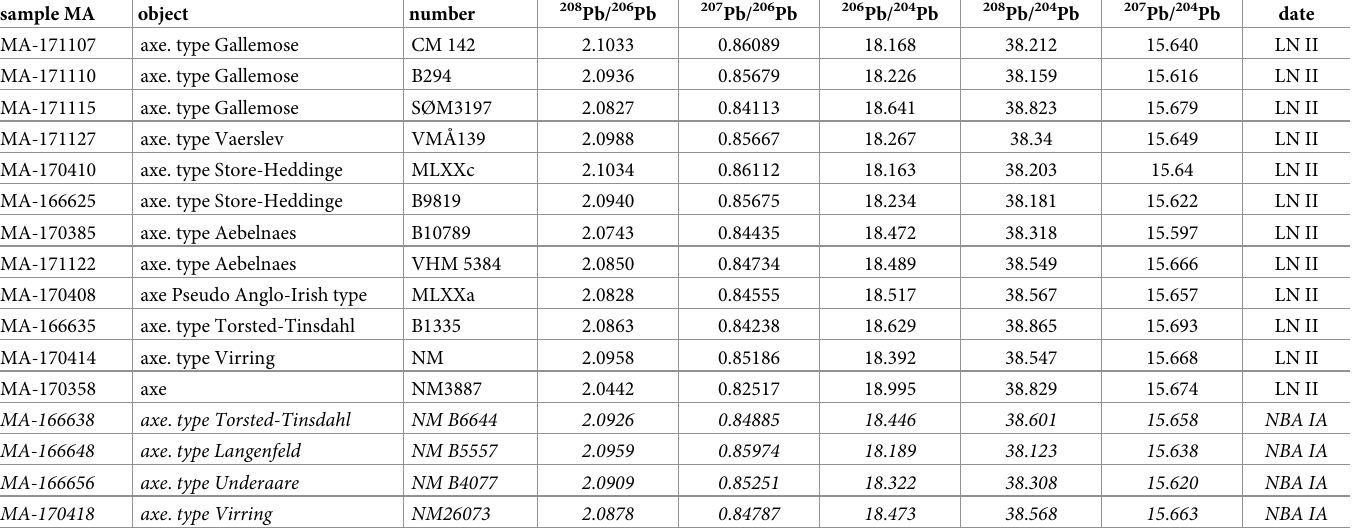
Table 2. Lead isotope ratios of artifacts of interest concerning the discussion of typological hybrids and foreign imports. sample MA